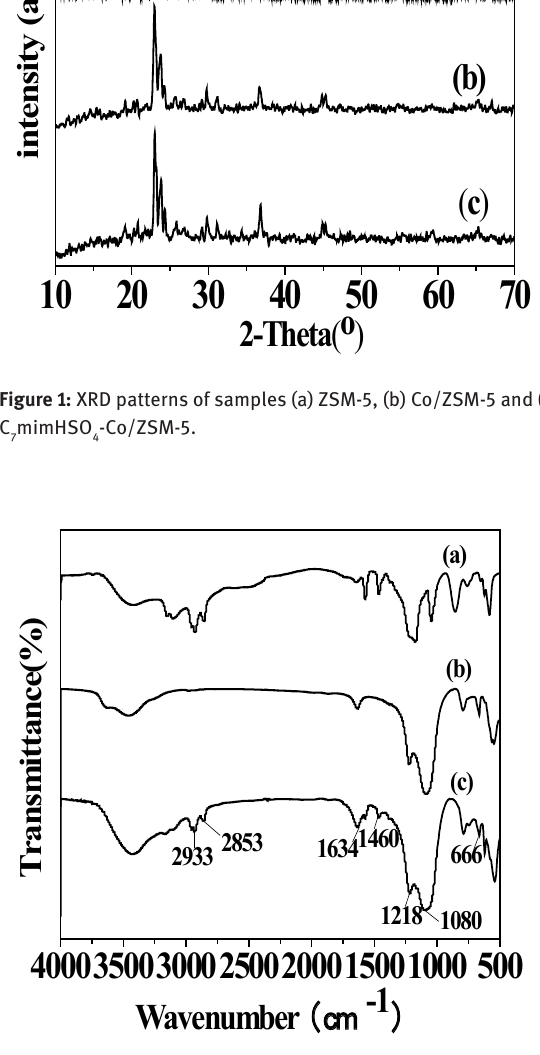
Figure 2: FT-IR spectra of (a) C and (c) C mimHSO 7 4